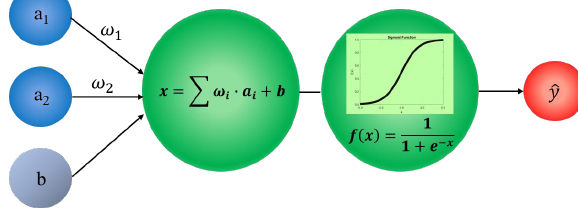
Figure 2. Layout of feedforward algorithm.